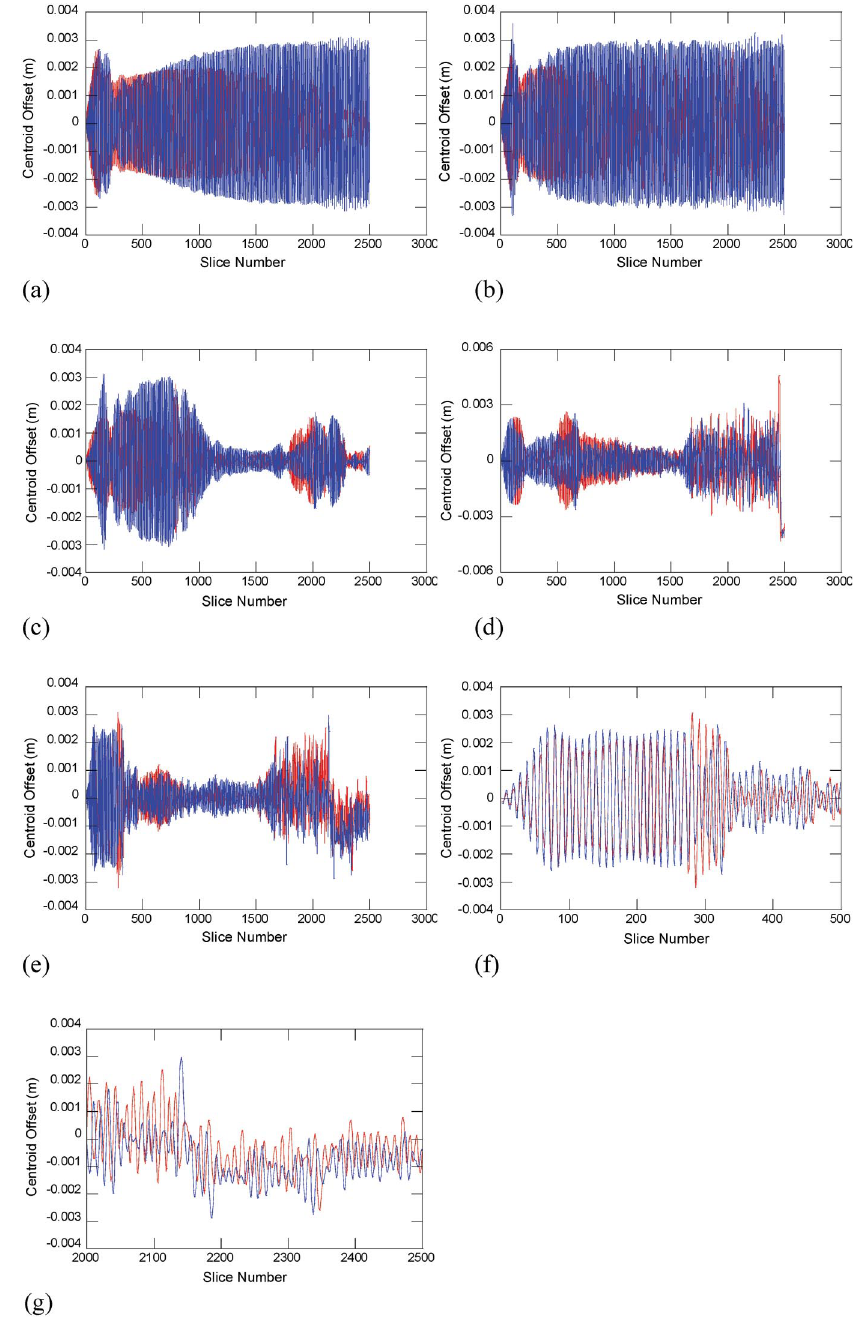
FIG. 18. (Color) Ion centroid evolution for 20-MeV, 3-mm, periodic-focusing beam case at different axial positions. Each slice is 0.4 nsec long. The red line is for the horizontal offset and the blue line is for the vertical offset. (a) z (cid:4) 1 m , (b) z (cid:4) 2 m , (c) z (cid:4) 3 m , (d) z (cid:4) 4 m , (e) z (cid:4) 5 m , (f) blowup of first 500 slices at z (cid:4) 5 m , and (g) blowup of last 500 slices at z (cid:4) 5 m